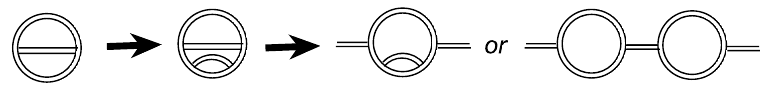
Figure 16 . An example of the recursive construction that generates the leading contributions to the 2-point function of the original double-line (meson) (cid:12)elds. The (cid:12)rst arrow represents the action of inserting one building block, as in (cid:12)gure 15. The third panel shows two di(cid:11)erent ways to get a 2-point graph by cutting one of the edges in the second